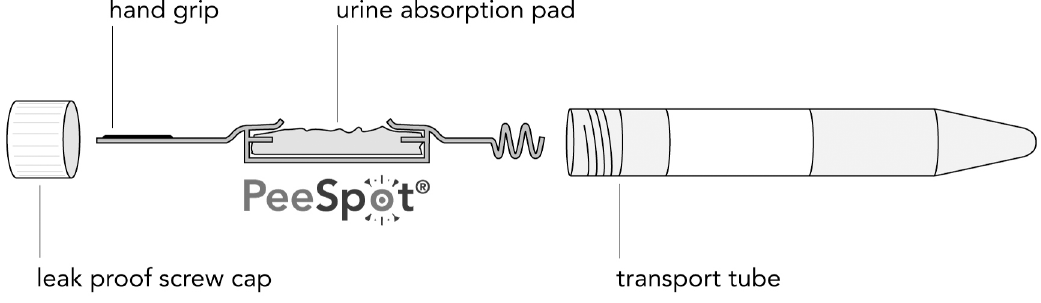
can void over the absorption pad while placed in the holder. After voiding, the pad and holder are placed in the tube, closed with the lid and kept in the refrigerator until sending to the labo- ratory. After completing the urine collections, the PeeSpots were placed in a safety bag and sent to the central laboratory in an envelope for biological materials (PolyMed, DaklaPack Europe) together with the questionnaire. Upon arrival at the laboratory, samples were pro- cessed within 24 hours. Previous studies have shown that albuminuria remains stable during storage on room temperature up to seven days.[4,5] Tubes were centrifuged for 5 minutes on 350G (Rotina 35R). Urinary albumin concentration (U ) was measured with the Roche Mod- AC ular P using the immunoturbimetric assay and expressed in mg/L. Urinary creatinine concen- tration (U ) was measured with the Roche Modular P using creatinase to sarcosine oxidase CR based colorimetric method and expressed in g/L. To correct U for urine dilution, urinary AC albumin:creatinine ratio (U ) was assessed. Urine samples were tested for leukocytes with ACR